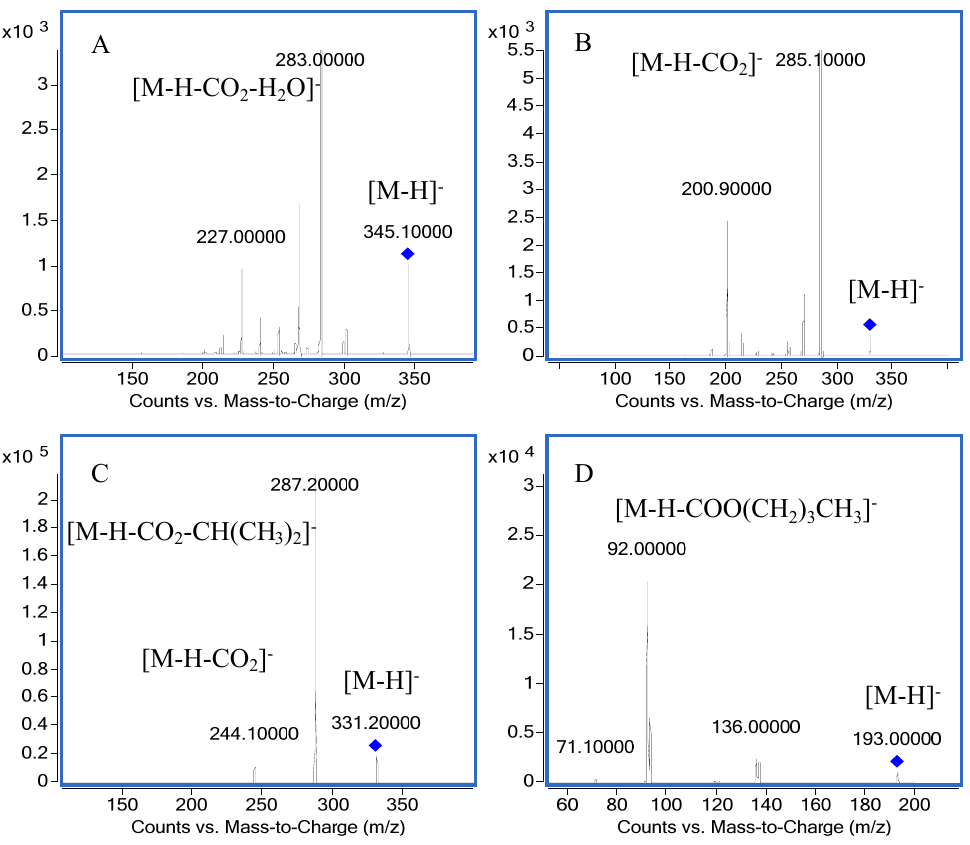
Figure 4. Product ion mass spectra of three analytes and I.S.: ( A ) rosmanol; ( B ) carnosol; ( C ) carnosic acid; ( D ) butylparaben.